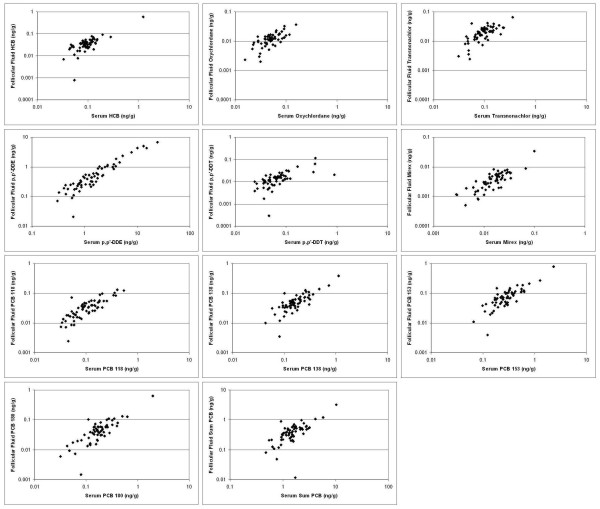
Scatterplots of organochlorine concentrations measured in first-cycle serum and follicular fluid (n = 62). Spearman correlation coefficients between media were as follows (all p-values < 0.05): HCB, 0.66; oxychlordane, 0.66; transnonachlor, 0.65; p,p'-DDE, 0.92; p,p'-DDT, 0.74; mirex, 0.80; PCB 118, 0.82; PCB 138, 0.74; PCB 153, 0.73; PCB 180, 0.73; Sum PCB, 0.68.